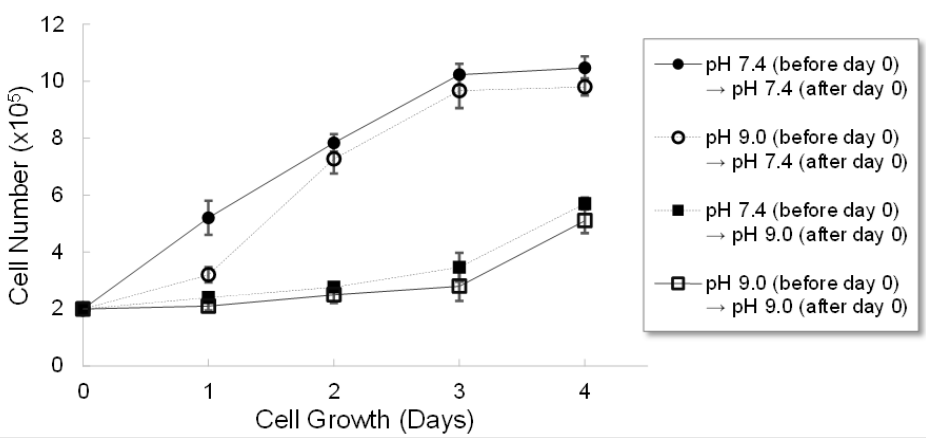
Figure 4. The effect of a medium change on the cell growth of MDA-MB-231 cells. MDA-MB-231 cells were grown in pH 7.4 or pH 9.0 DMEM. The cells in each pH were trypsinized and splitted